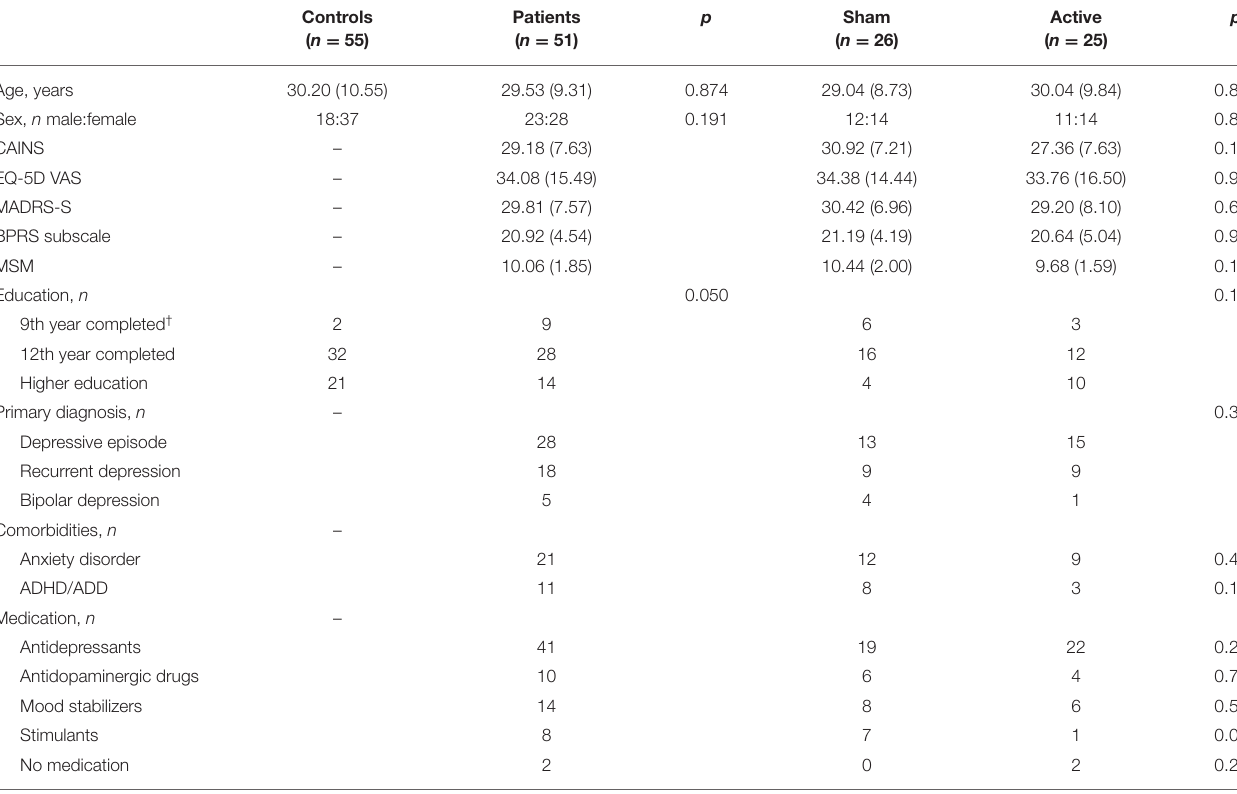
TABLE 2 | Baseline demographic and clinical characteristics [Mean (SD)] of controls and patients, and the patients further divided into sham and active iTBS treatment allocation, and the respective statistical tests. Controls ( n =